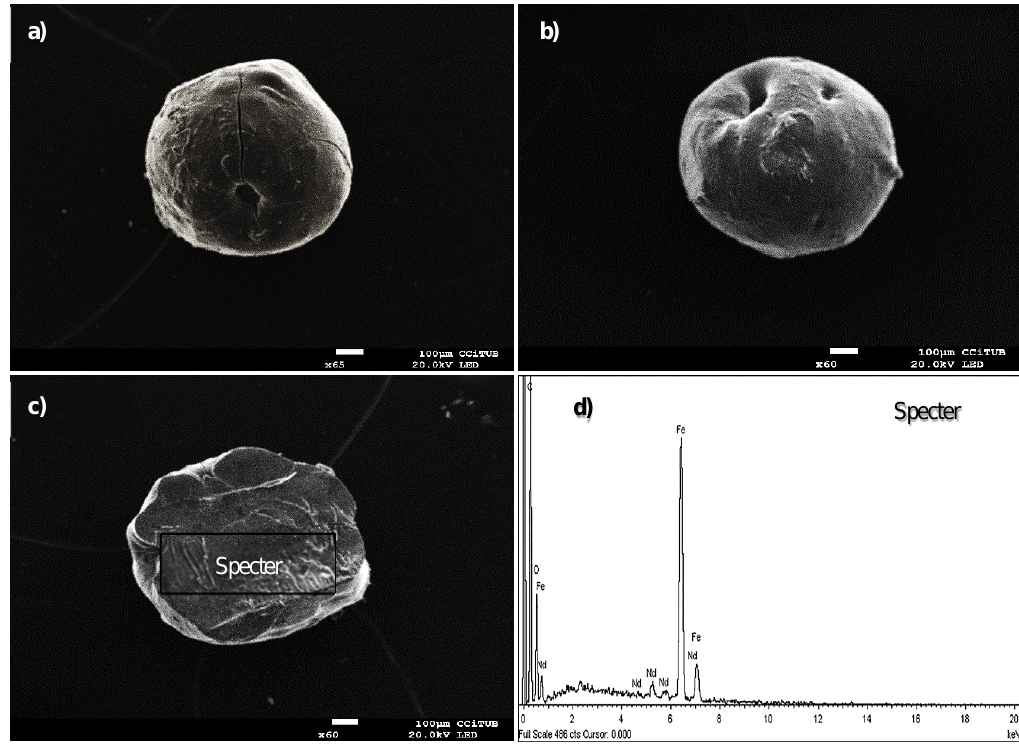
Figure 2. Scanning electron microscopy (SEM) images of the air dried (AD) sorbent. ( a ) External surface. ( b ) Cross-section area. ( c , d ) Energy dispersive X-ray (EDX) analysis of the cross-section area of the beads.